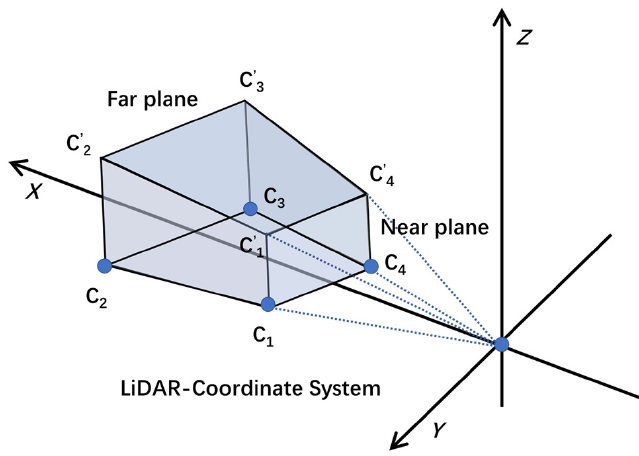
Figure 2. The viewing frustum of the camera.